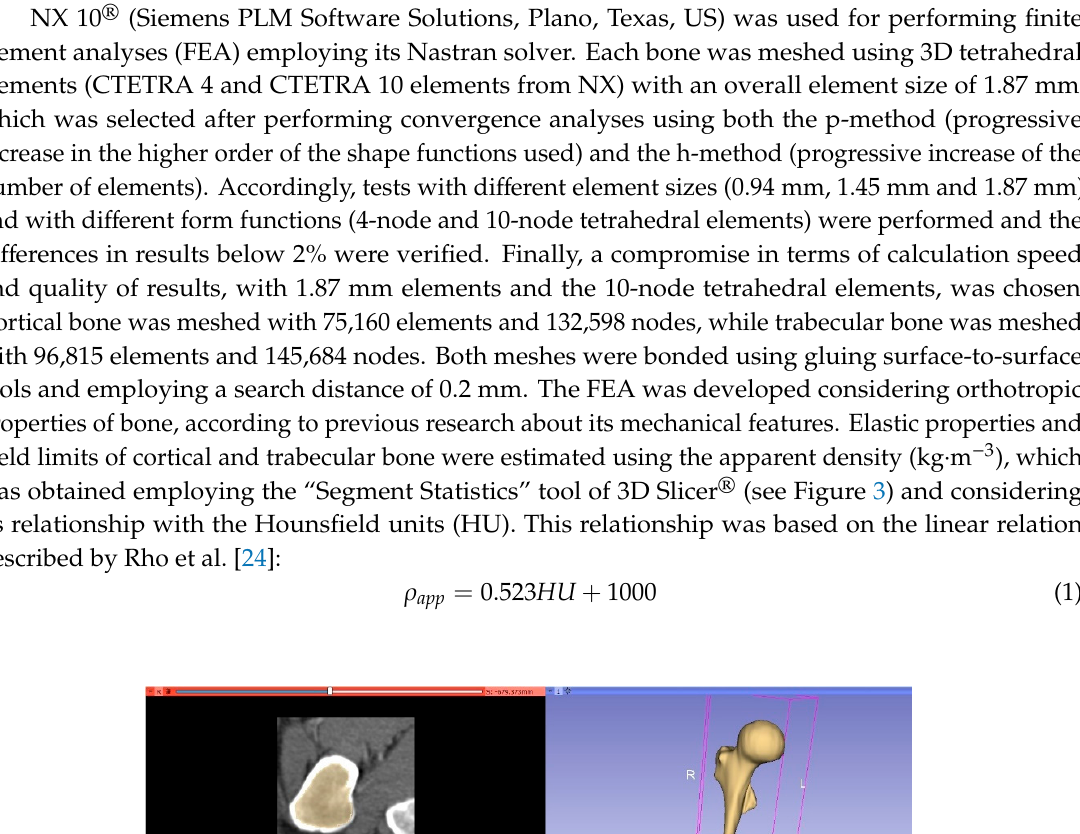
Figure 2. ( A ) The segmentation of right femur using 3D Slicer ® . ( B ) The process to obtain the trabecular bone using Logical Operators tool.